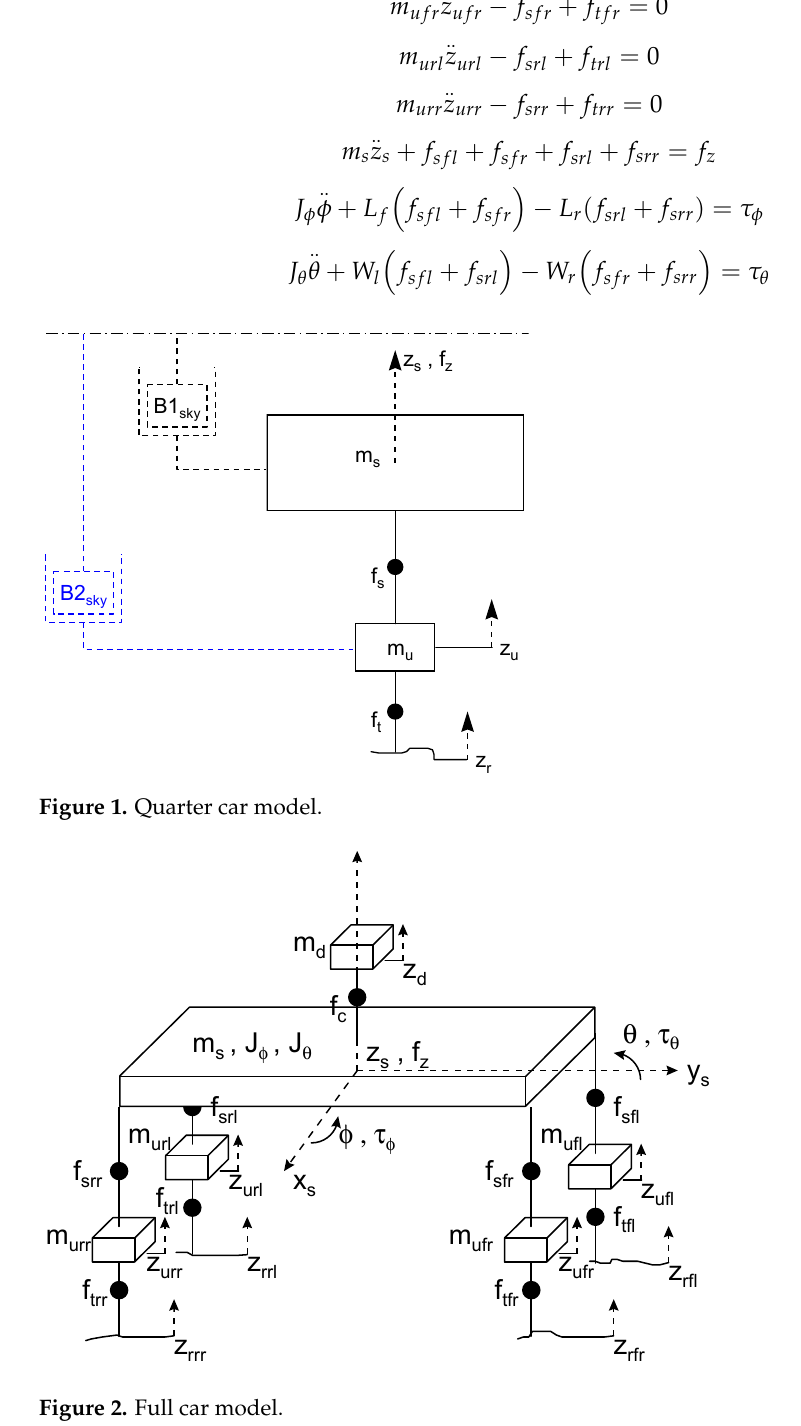
Figure 2. Full car model.